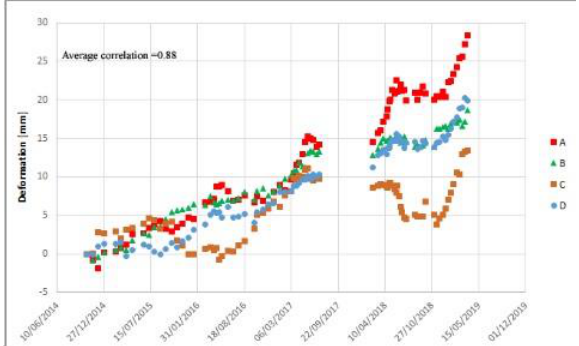
Figure 5. Displacement time series at different areas of the Copiapó river. A, B, C and D of Figure 4. The average correlation between them is 0.88.